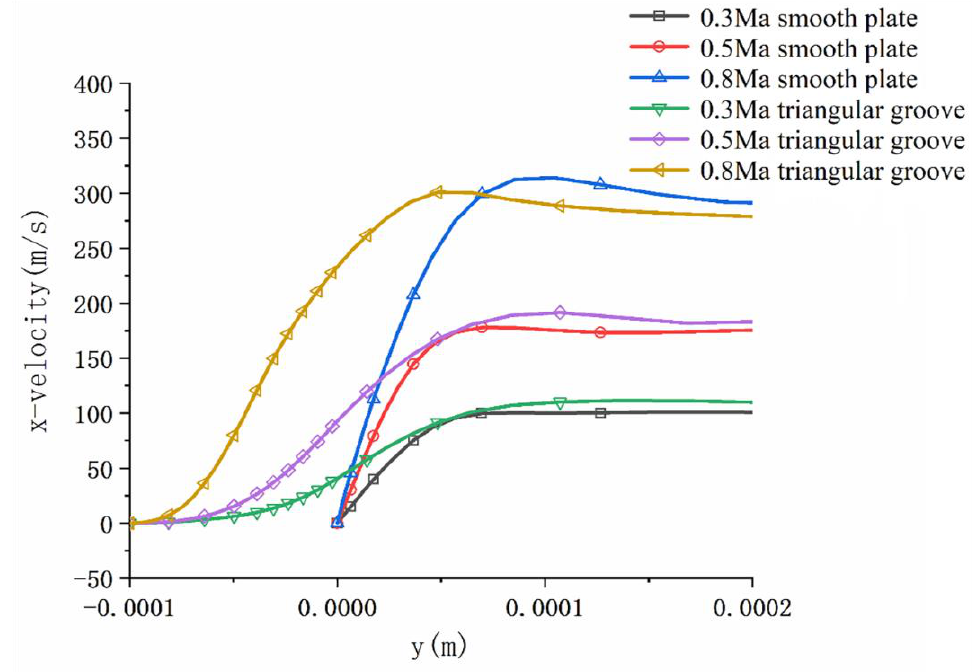
Figure 15. Velocity profiles of triangular groove and smooth plate under different Mach numbers. Since the triangular grooves were longitudinally arranged in the spanwise direction and extended along the flow direction, there was a height difference of the wall in the span, and the velocity distribution could not be fully understood from the spanwise plane alone. Therefore, the spanwise plane at flow direction x = 0.00375 m was selected to make the velocity distribution cloud picture, as shown in Figure 16. As the velocity increased, the thickness of the boundary layer decreased in the spanwise direction; however, the variation of the thickness of the boundary layer in the spanwise direction was not the same at each point but fluctuated with the position. Under the above simulated velocity conditions, the boundary layer at the top of the groove was relatively the thinnest. At the bottom of the groove, the boundary layer thickness was the largest, and the change of boundary layer thickness with velocity was also the largest. At 0.8 Ma, the shape of the spanwise section of the boundary layer began to be close to that of the groove. It can be judged that as the velocity continued to increase, the boundary layer would further fit the groove, and the thickness difference of the boundary layer in the spanwise direction would